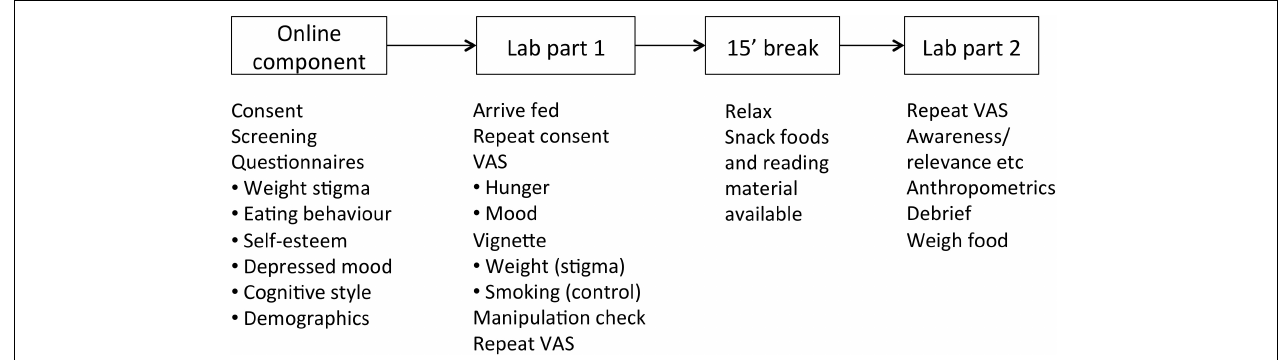
FIGURE 1 | Schematic overview of study